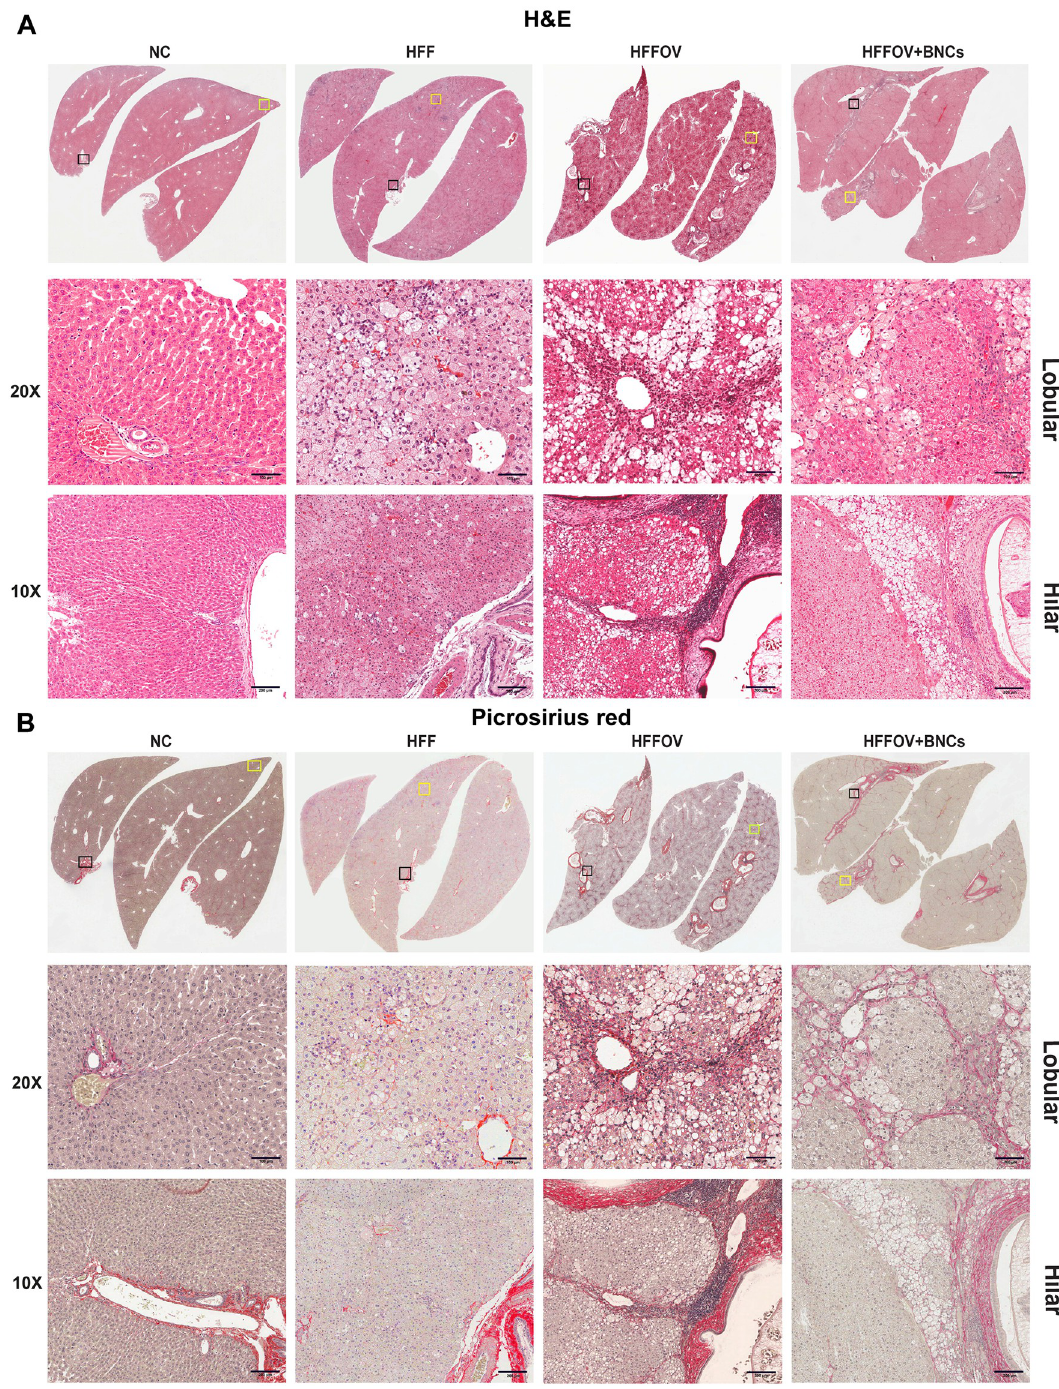
Fig 4. Histopathological changes induced by O . viverrini infection and HFF diet. A): H&E stain was used to demonstrate abnormalities in the liver; and B): Picrosirius red stain was used to investigate fibrosis. Experimental animal groups and abbreviations are the same as in Fig 3